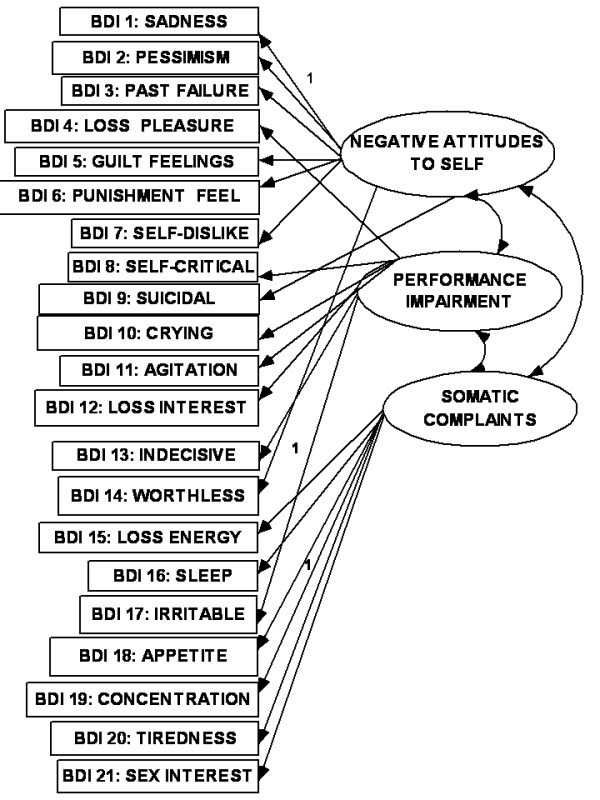
3-factor lower order model.